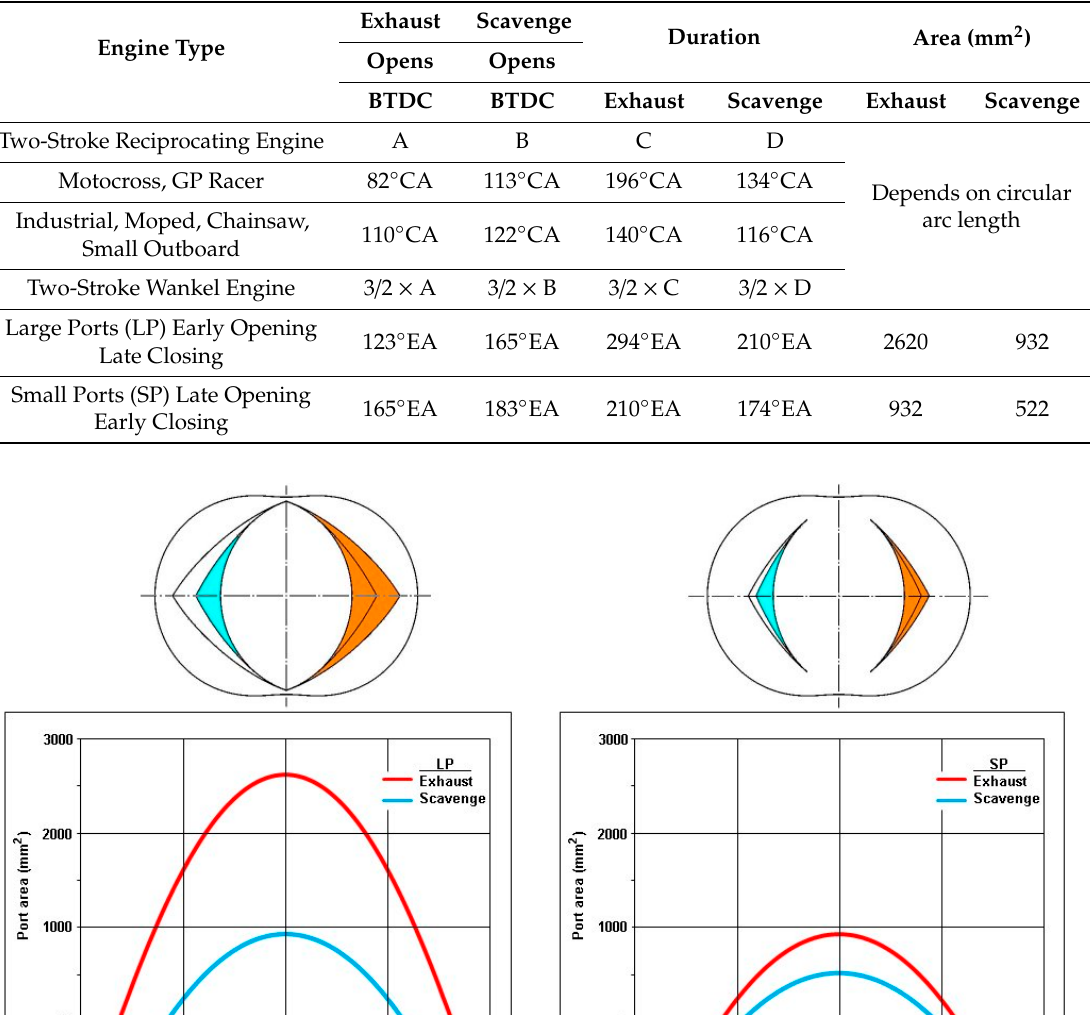
Table 2. Typical port configurations for two-stroke reciprocating engines [26] and conversion to the two-stroke Wankel engine.